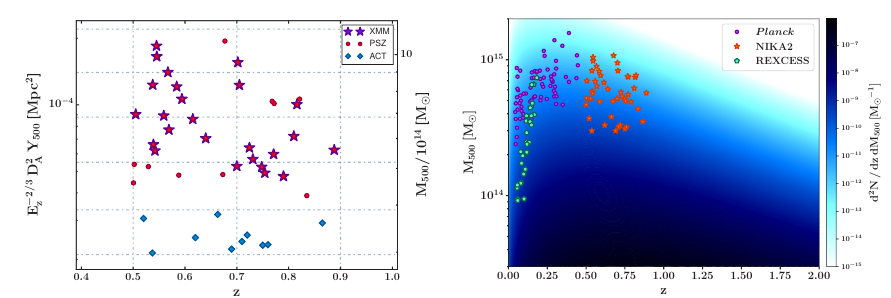
Figure3. Distributionofthe62 Planck clustersusedinordertoestimatethemeannormalizedpressureprofileatlowredshift(purple)inthemass-redshift plane.TheNIKA2andREXCESSsamplesarealsoshowninorangeandgreenrespectively.Thedi ↵ erentshadesofbluegivetheexpectedclusterabundance, i.e. theclusternumberperunitofmassandredshiftcomputedfromEq.(10). Figure 1. Left: Distribution of the LPSZ cluster sample in the plane of the redshift (abscissa) and the integrated Compton parameter (ordinate). The corresponding mass, as derived from the Planck Y-M scaling relation is given in the right ordinate-scale. The sample comprizes clusters drawn from the Planck (red) and ACT (blue) catalogs [10, 11], and already observed by XMM-Newton (stars). Right: Comparison of the LPSZ sample (red) with previous samples dedicated to the cluster mass calibration [3, 4] in the mass-redshift plane color-coded as a function of the predicted cluster abundance. Figure extracted from